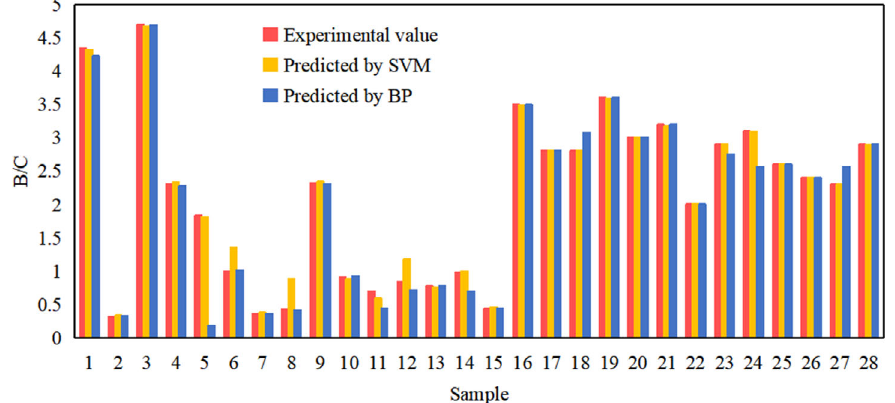
Fig. 9 Predicted B/C with reactor scale (input variables are T , P , BCl 3 , CH 4 , BHCl 2 , BHCl 3 , BCl 2 , HCl, and H 2